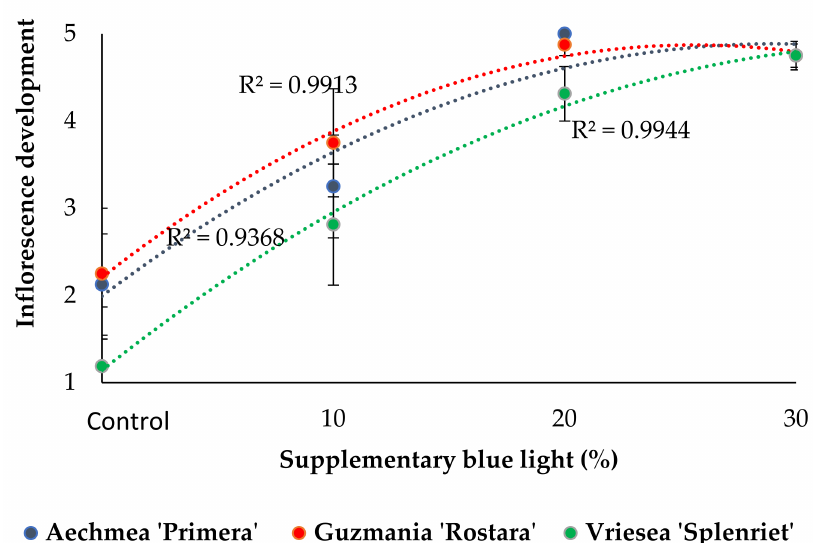
Figure 4. Inflorescence development as a function of the supplementary light percentage of blue in the three species under study. Supplementary light included R90B10 [90% red (R) and 10% blue (B)], R80B20 (80% R and 20% B), and R70B30 (70% R and 30% B). Control plants did not receive supplementary light. Data of the two EC treatments were pooled. The scale (1 to 5) characterizing inflorescence development is provided in Figure 1. Eight replicate plants were assessed per treatment. Error bars represent